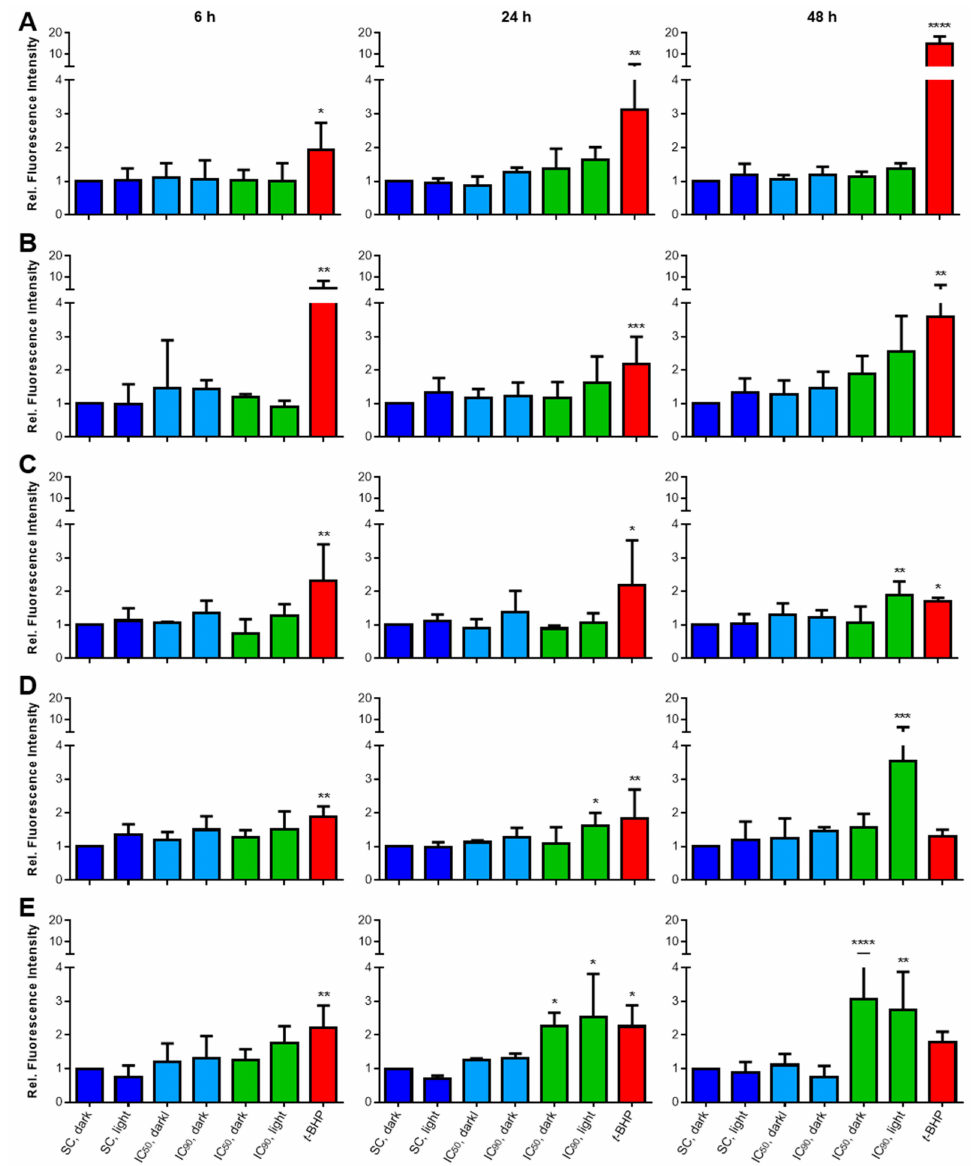
Figure 4. Analysis of LPO after mTHPC-PDT in A-427 ( A ), BHY ( B ), KYSE-70 ( C ), RT-4 ( D ), and SISO ( E ) cells. Cells were treated with solvent (SC) or equitoxic concentrations (IC 50 or IC 90 in Table 1) of mTHPC between 0.02–0.3 µ M, illuminated with 1.8 J / cm 2 or left in the dark, stained with BODIPY 665 / 676 and fluorescence intensity was measured 6 (left), 24 (middle), or 48 h (right) after illumination. Flow cytometric analysis of the single cell population was carried out using the APC channel ( λ Ex / Em = 635 / 655–730 nm). Fluorescence intensity was plotted with reference to non-illuminated, solvent-treated cells (fluorescence intensity was set to 1.0). Cells treated with 0.4–3.0 mM t -BHP for 24 h (A-427: 0.2–0.4 mM t -BHP for 4 h) were used as positive control. Data presented as means ± SD from at least three independent experiments. (* p < 0.05; ** p < 0.01; *** p < 0.001; **** p < 0.0001). 2.3.3. Total Loss of Mitochondrial Membrane Potential ( δψ M) after mTHPC-PDT To evaluate the e ff ects of mTHPC-PDT on mitochondrial membrane potential ( ∆ ψ m ), a widely used procedure was applied for staining the mitochondrion with the cationic dye JC-1. Green fluorescent JC-1 monomers and red fluorescent JC-1 aggregates were visualized by fluorescence